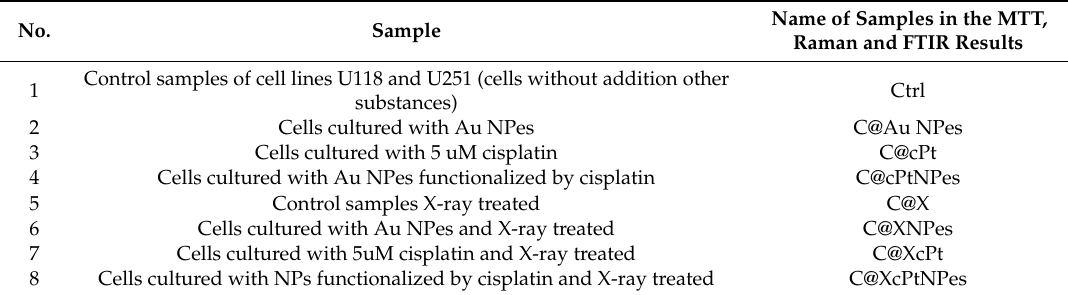
Table 1. Description of cells